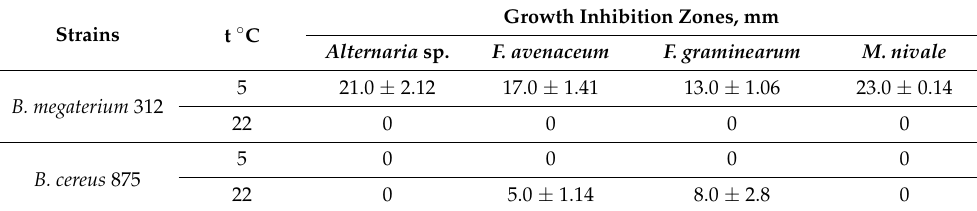
Table 1. Antifungal activity of the strains of Bacillus spp. depending on the cultivation temperature.